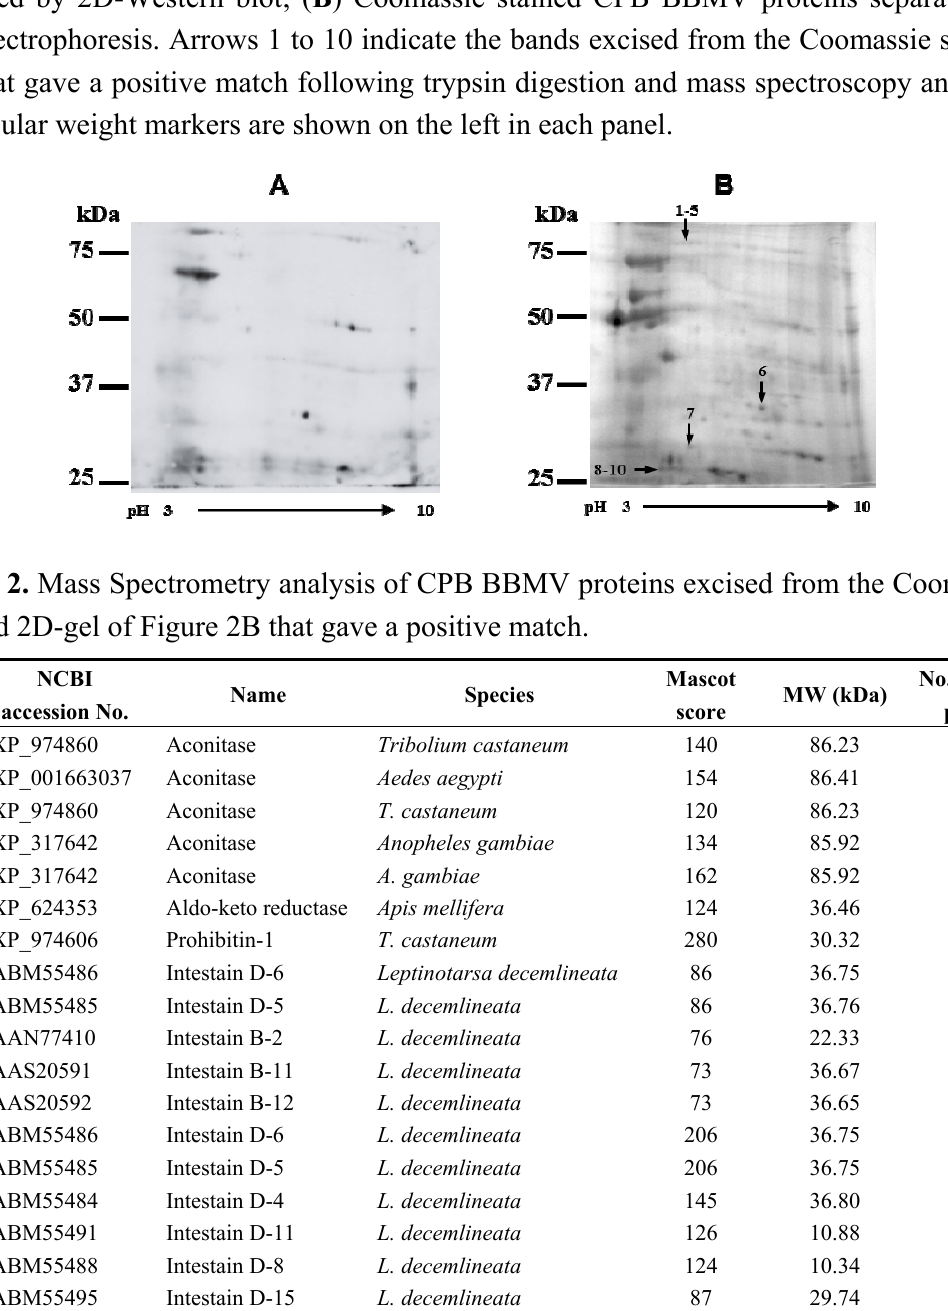
Figure 2. Identification of CPB midgut cysteine proteases that interact with Cry3Aa toxin. ( A ) Bt Cry3Aa toxin biotin-labeled with the trifunctional crosslinking reagent Sulfo-SBED was incubated with CPB BBMV, and following photoactivation, DTT was added. The detected by 2D-Western blot; ( B ) Coomassie stained CPB BBMV proteins separated by